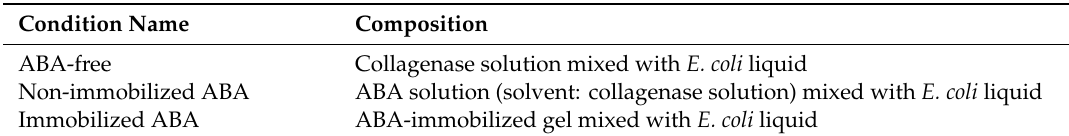
Table 3. Composition of the